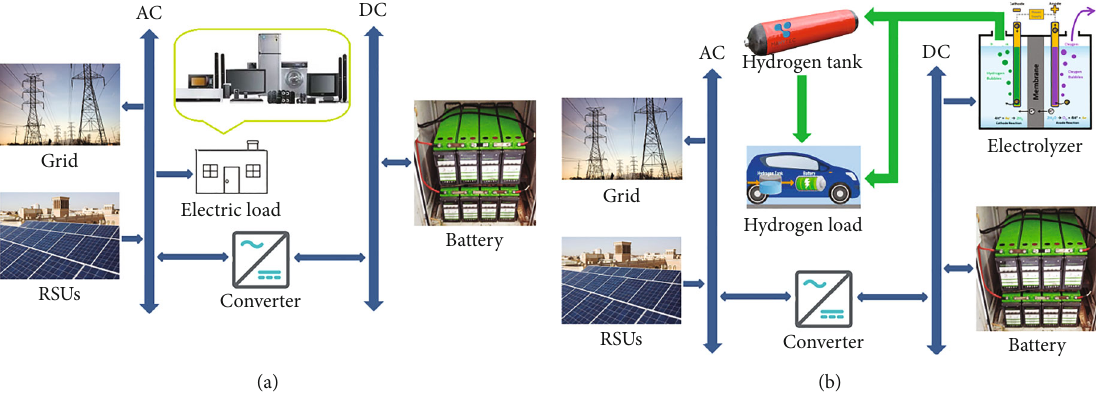
Figure 3: Schematic of the solar system to generate (a) electricity and (b) hydrogen.